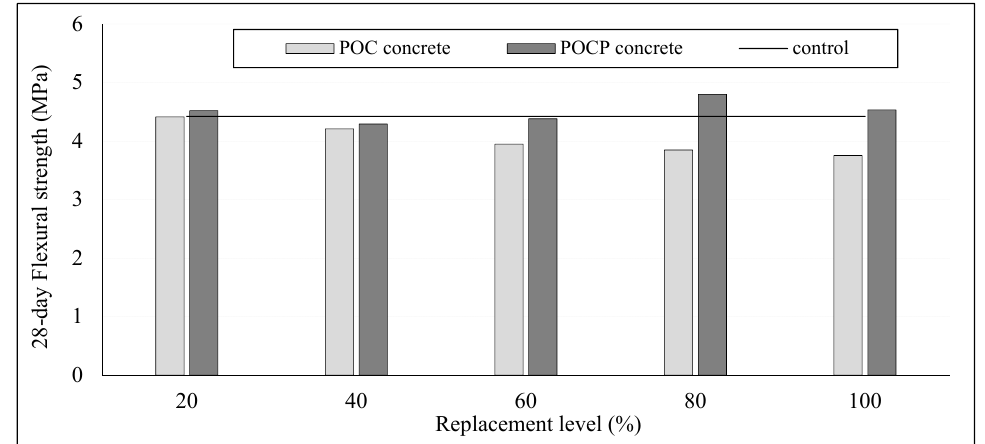
Figure 21. 28-day Flexural strength of POC and POCP concrete.